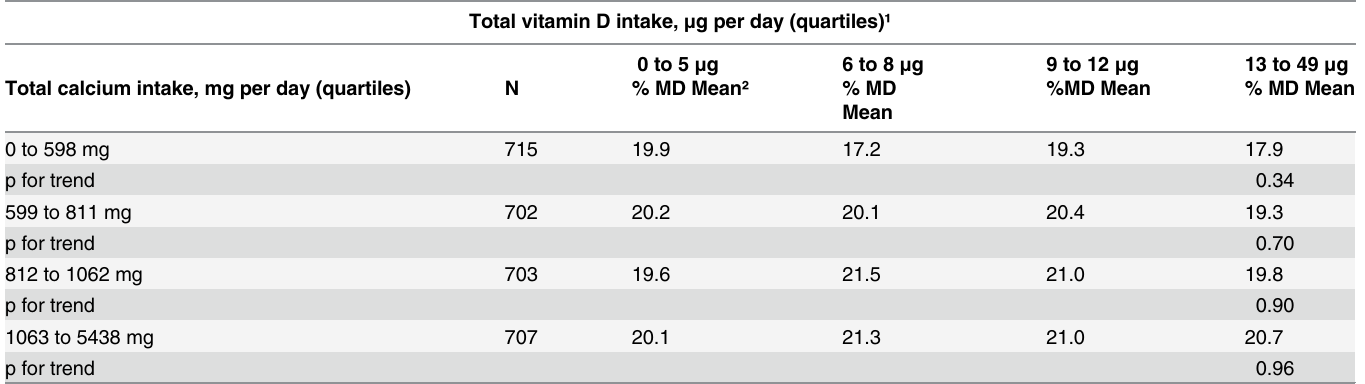
Table 5. Percent mammographic density (%MD) by total vitamin D intake (quartiles), stratified by total calcium intake (quartiles) (N =